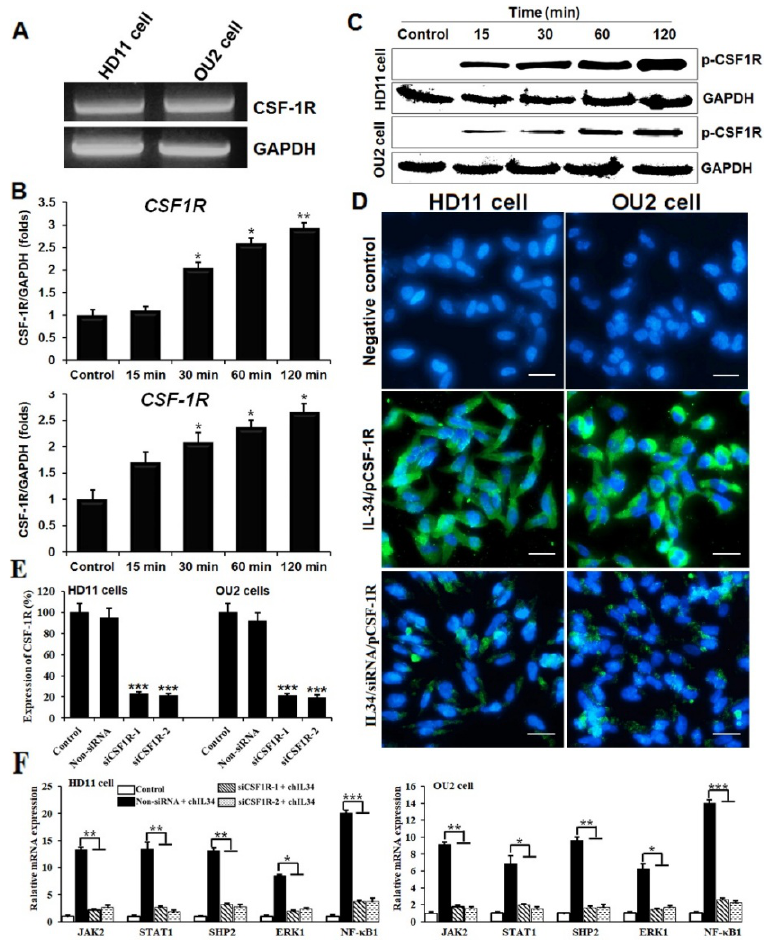
Figure 1. Colony-stimulating factor receptor (CSF-1R) is expressed in chicken cell lines. ( A ) Expression of CSF-1R analyzed by real-time quantitative polymerase chain reaction (qRT-PCR) on mRNA derived from chicken cell lines as indicated. ( B ) CSF-1R mRNA expression in macrophage (HD11) cells (above) and fibroblast (OU2) cells (below) induced by interleukin-34 (IL-34), measured by qRT-PCR and normalized to glyceraldehyde-3-phosphate dehydrogenase ( GAPDH ). ( C , D ) CSF-1R protein expression as demonstrated by western blot analysis and immunocytochemical staining with the CSF-1R antibody in HD11 (left) and OU2 (right) cells using an Alexa Fluor ® 488-conjugated goat anti-rabbit IgG (H + L) secondary antibody and 4′,6-diamidino-2-phenylindole (DAPI) (blue). Scale bar represents 10 µm. ( E ) Inhibition of chicken CSF-1R mRNA expression by CSF1R-specific siRNA in HD11 and OU2 cell lines. Cells were transfected with non-siRNA, siCSF1R-1, and siCSF-1R-2 for 48 h and subjected to qRT-PCR analysis. ( F ) After transfection with siCSF-1R-1, siCSF1R-2, or non-siRNA, cells were stimulated with recombinant chIL-34 (200 ng/mL) for 24 h (non-siRNA used as a negative control). Data are presented as the mean ± SEM ( n = 3) of 3 independent experiments. * p < 0.05, ** p < 0.01, and *** p < 0.001.